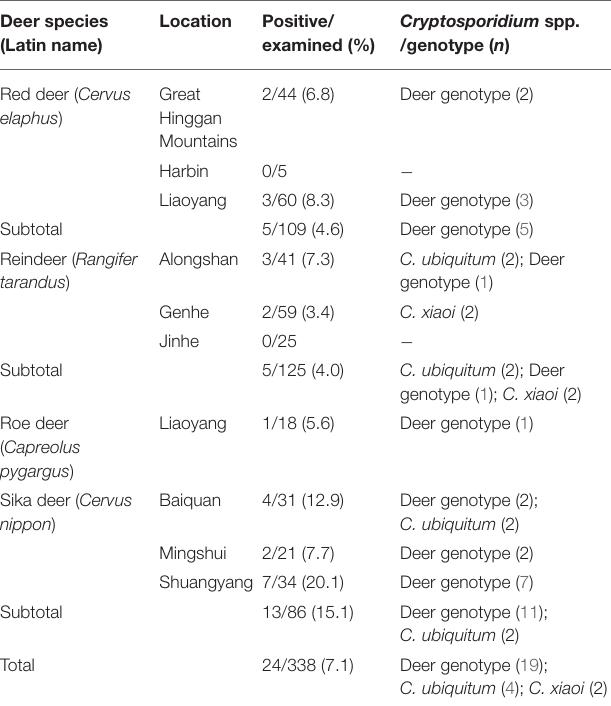
TABLE 2 | Prevalence and species/genotypes of Cryptosporidium in the investigated deer species in China. Deer species (Latin